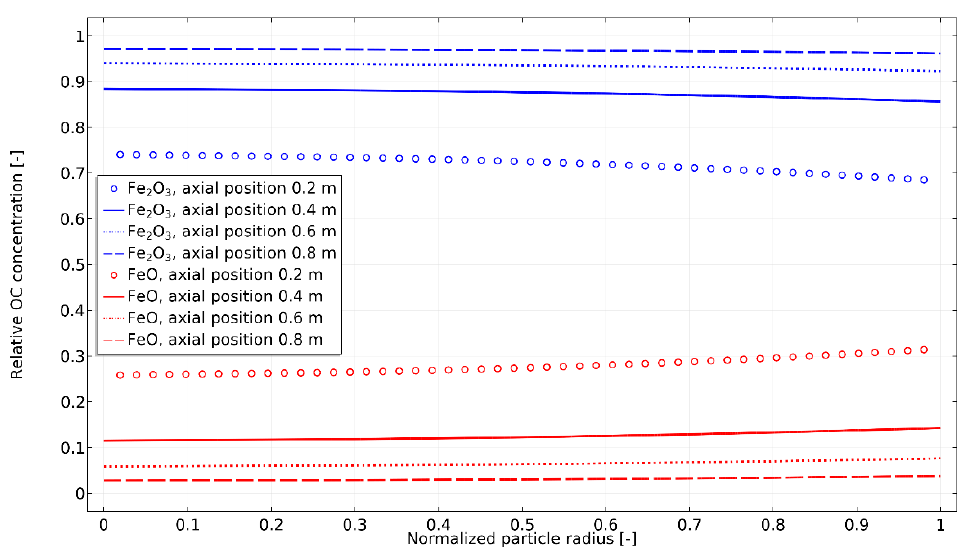
Figure 14. Change in concentration of the iron oxides within four particles selected at various axial positions inside the bed at simulation time 60 s.